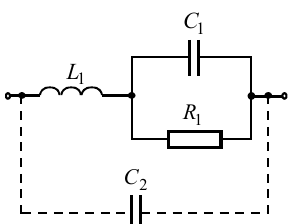
Figure 2. Equivalent circuit model, for a solid state substrate samples with GZO piezoelectric films.